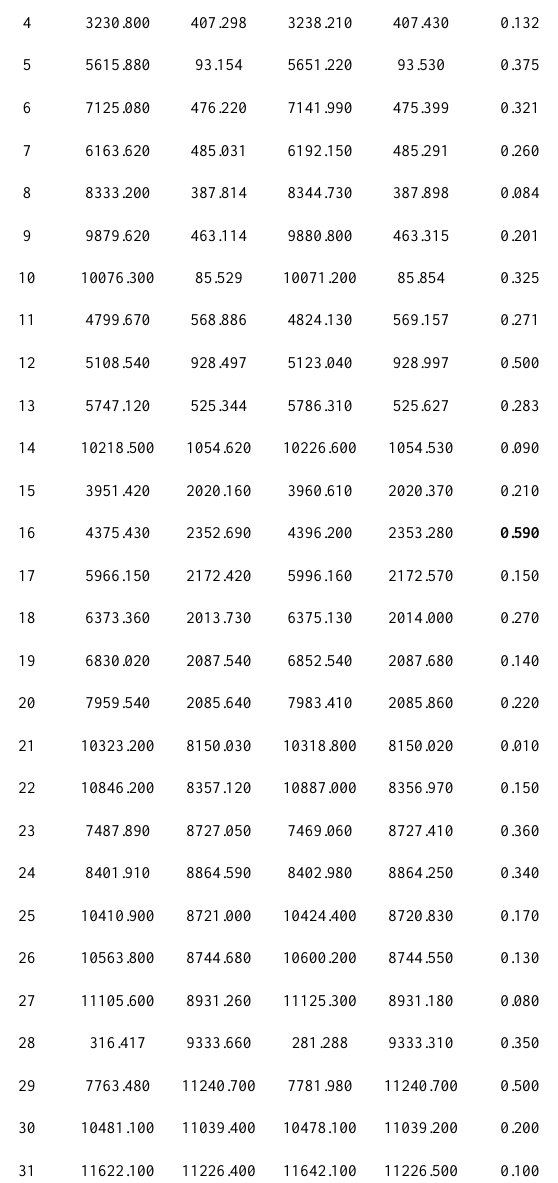
Table 9. The Vertical Parallax evaluation 𝑥 1 is the column value of the corresponding point on the forward epipolar image, and 𝑦 1 is the row value; 𝑥 2 is the column value of the corresponding point on the back epipolar image, while 𝑦 2 is the row value. The vertical parallax (abs ( 𝑦 2 - 𝑦 1 ) ) of the epipolar image is computed to describe the precise of epipolar images, especially the left and right edge points. Table 1